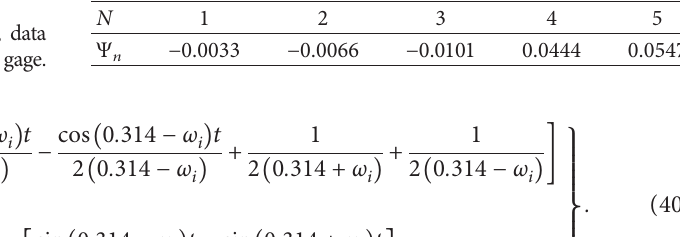
Table 2: First five order load coefficients of the beam in the experiment.